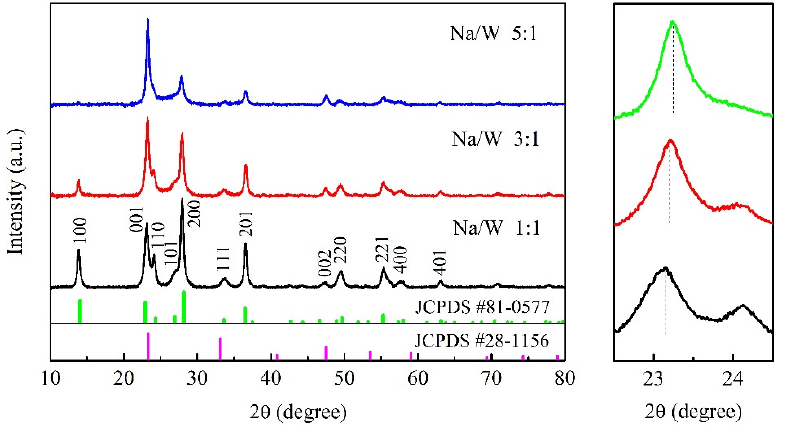
Figure 2. XRD patterns of the obtained powders ( left ) and partial enlarged view ( right ).